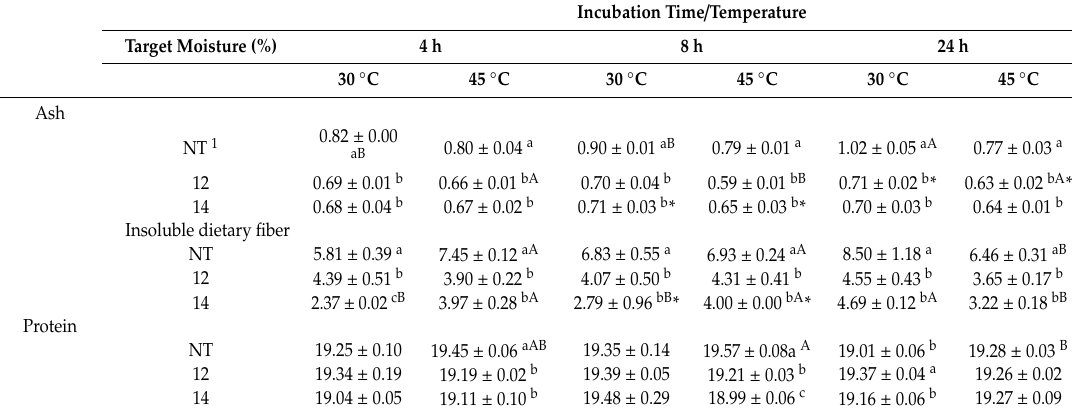
Table 3. Ash, insoluble dietary fiber, and protein contents of intermediate wheatgrass flour (g / 100 g, dry basis) as a ff ected by tempering